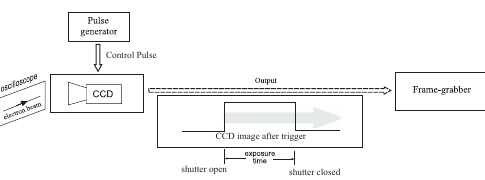
Figure 13. A charged coupled device (CCD) camera and frame grabber are used to measure the fluorescence of an electron beam as it sweeps across the screen of an analog oscilloscope. A pulse generator is used to generate a TTL pulse that controls the shutter of the CCD camera.